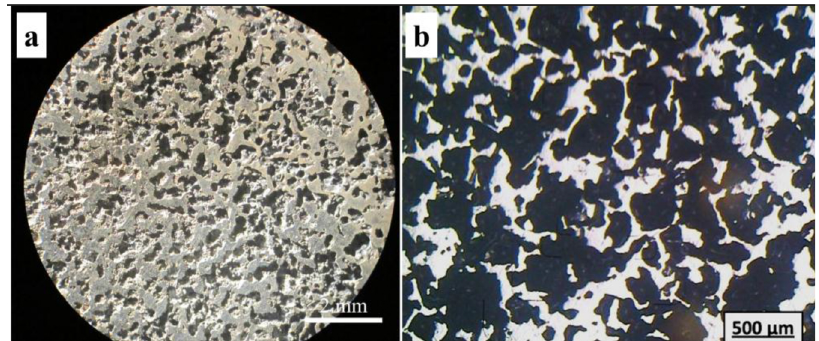
Fig. 2. Macroscopic image (a) and microscopic image (b) of the specimen with 70%